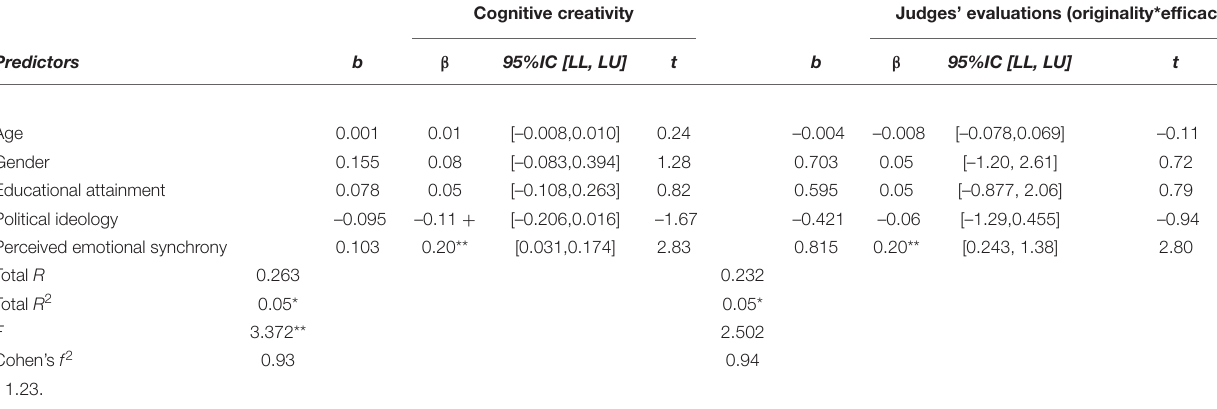
TABLE 4 | Multiple regression analyses predicting creativity indexes by collective